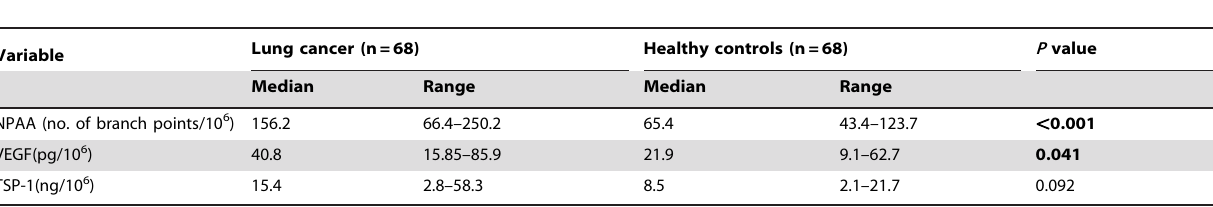
Table 1. Platelet Derived VEGF, TSP-1Concentration and NPAA in Lung Cancer and Control Study Groups.